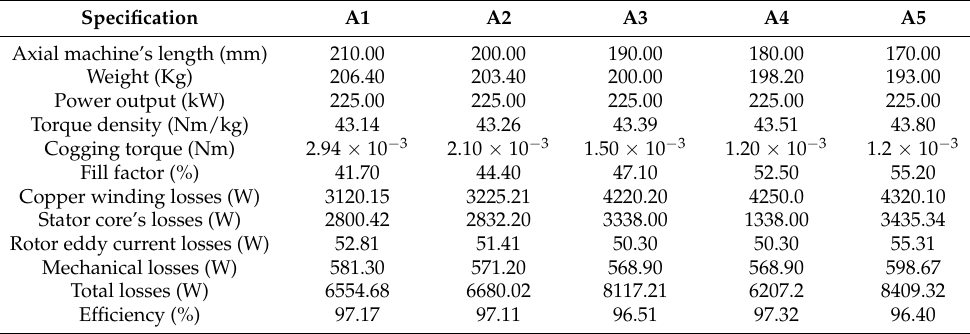
Table 4. Comparison for the electromagnetic performance of all the analytical